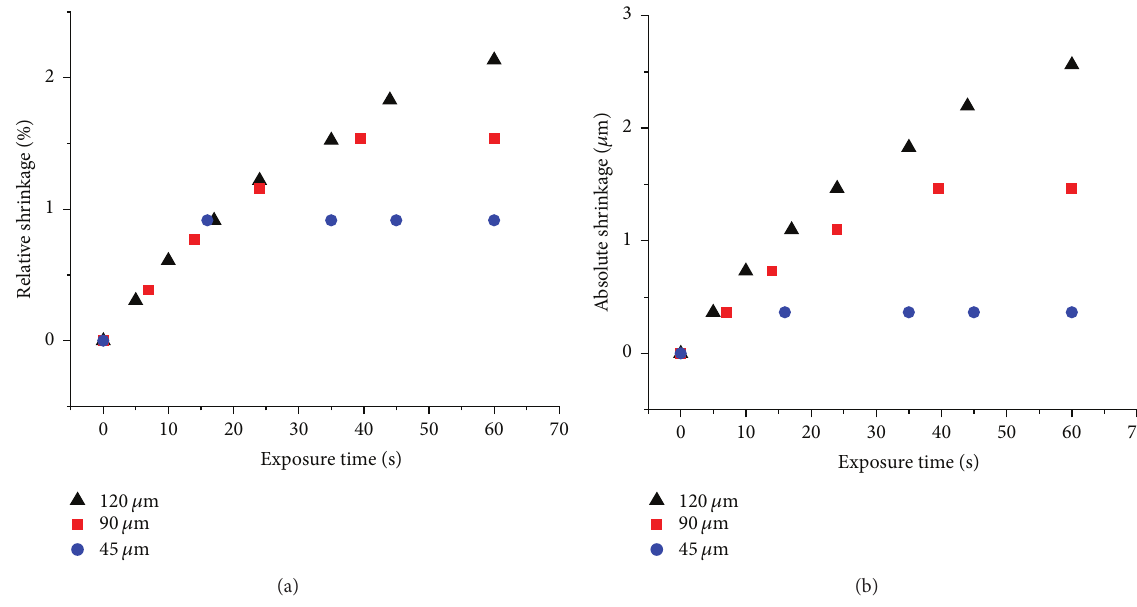
Figure 5: (a) Relative shrinkage (%) versus exposure time (s) and (b) absolute shrinkage ( 𝜇 m) versus exposure time (s) for gratings recorded in DA photopolymer layers with thickness of 45, 90, and 120 𝜇 m using a recording intensity of 1mW/cm 2 .